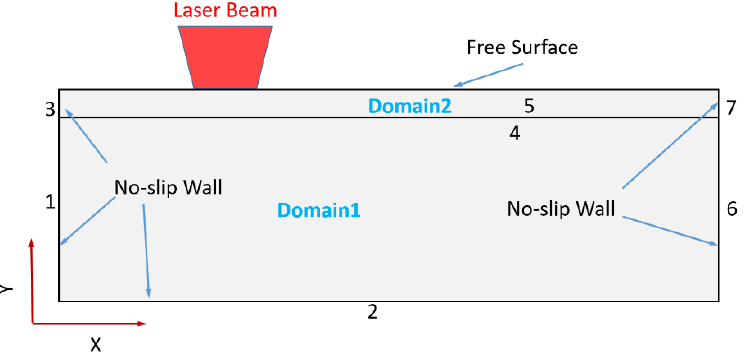
Figure 1. Geometry model of the molten